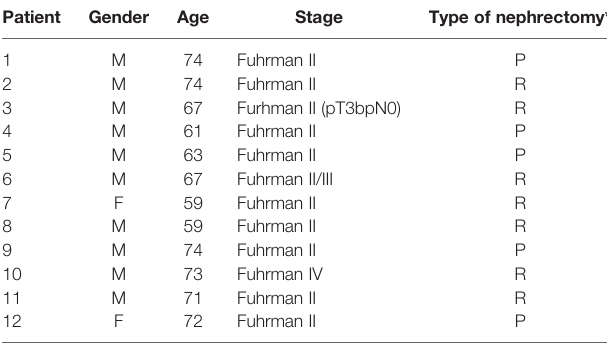
TABLE 1 | Patients with ccRCC included in the